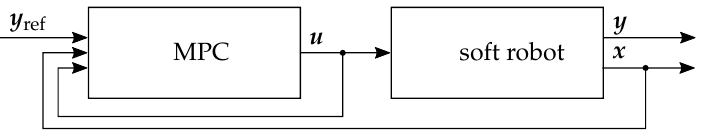
Figure 9. Block diagram of the closed control loop with the model predictive controller.